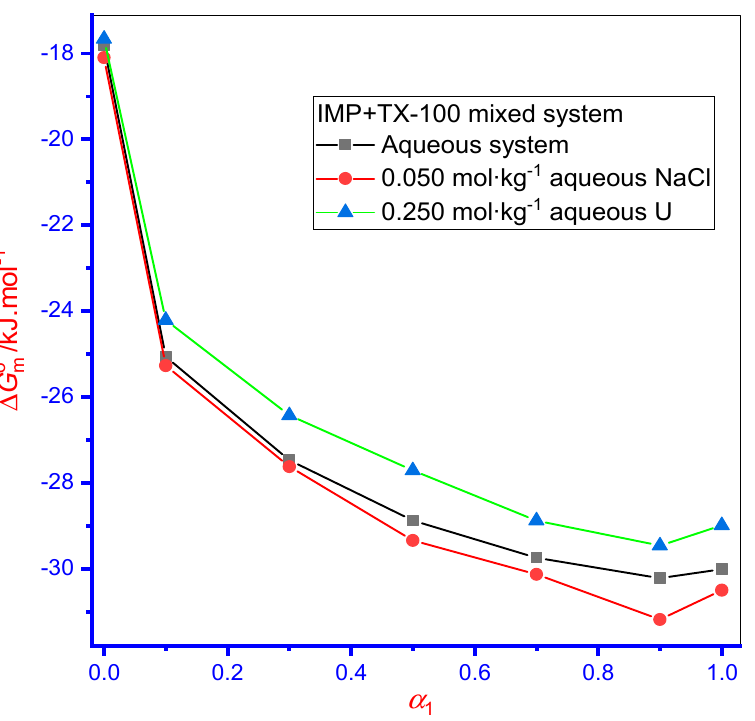
Figure 3. Variation in ∆ G o m value with the change in mole fraction ( α 1 ) of TX-100 in different media. a Relative standard uncertainties ( u r ) is u r ( ∆ G o m ) = ±